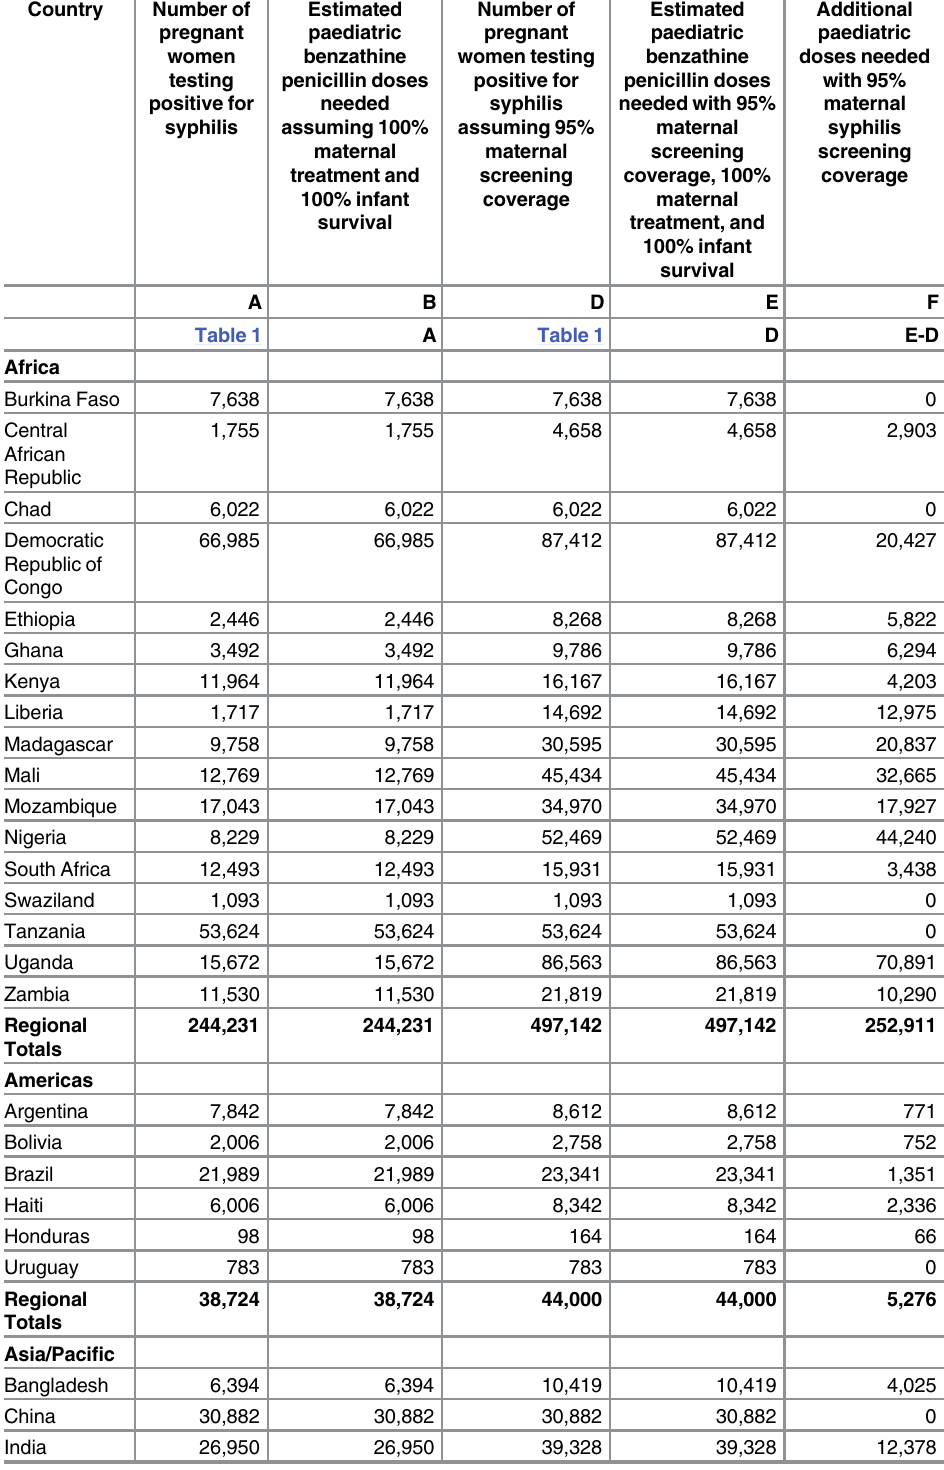
Table 2. Estimated paediatric benzathine penicillin regimens needed for treatment of infants exposed to syphilis during pregnancy in 30 high-morbidity